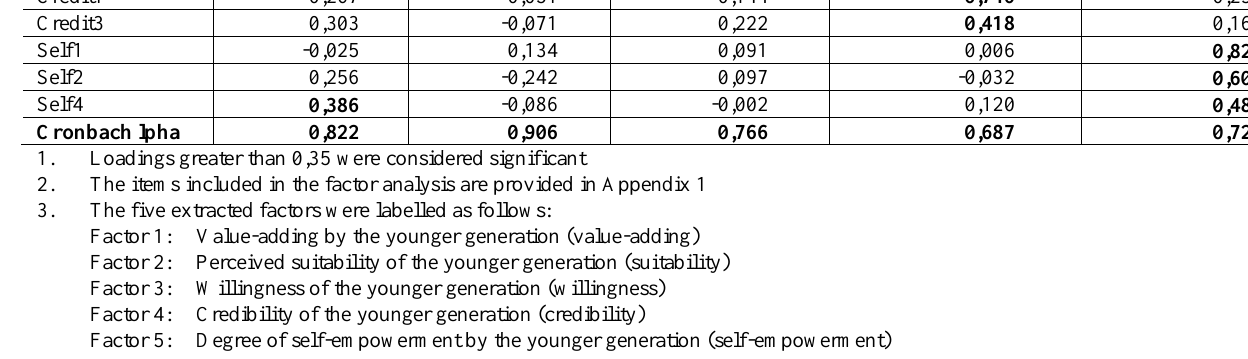
Suit1, Suit3, Suit4 and Suit5), loaded onto factor two as expected. Three willingness of the younger generation items (Table 2: Will2, Will3 and Will4) also loaded onto factor two. One value-adding by the younger generation (Value1) and one self-empowerment of the younger generation